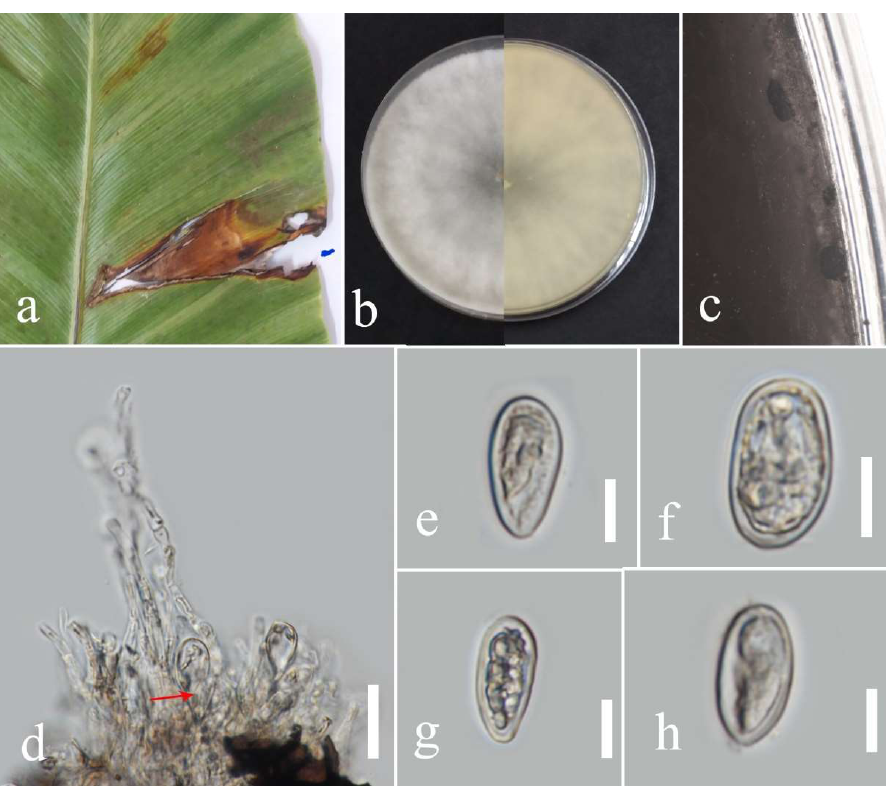
Figure 2. Morphology of Lasiodiplodia thailandica (MFLUCC 22 - 0161): ( a ) blight spots on